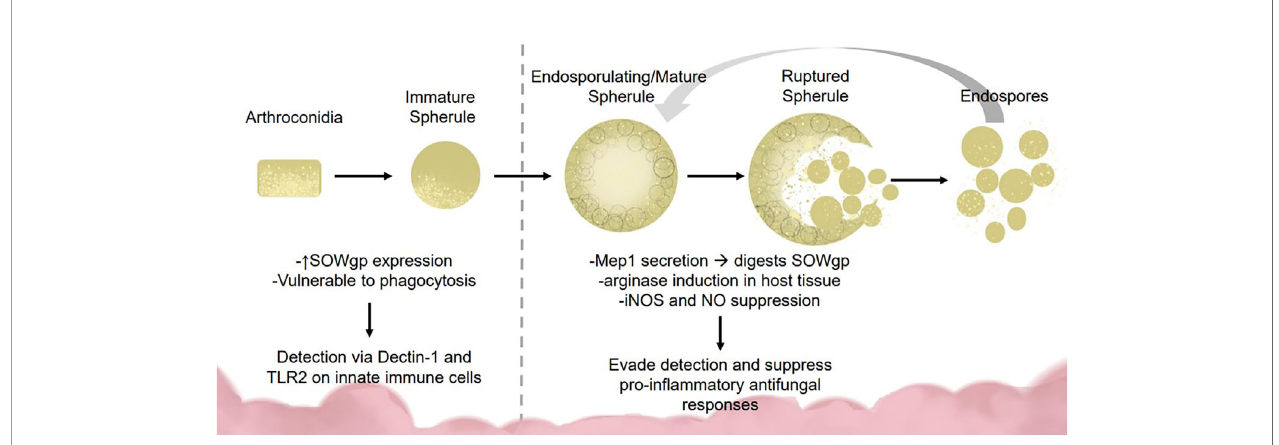
FIGURE 1 | Fungal dimorphism presents challenges for immune detection and activation. Early infection: Coccidioides is vulnerable to immune detection during early infection due to the smaller size (2 – 5 m M) and SOWgp expression which is detected via Dectin-1 and TLR2 on innate immune cells. These interactions mediate clearance via phagocytosis and reactive oxide species production. Later infection: As Coccidioides sporulates, it secretes MEP1 which digests SOWgp from the fungal surface, hampering immune detection. Spherules induce arginase expression in host tissues, suppressing NOS/NO production via an unknown mechanism, contributing to immune